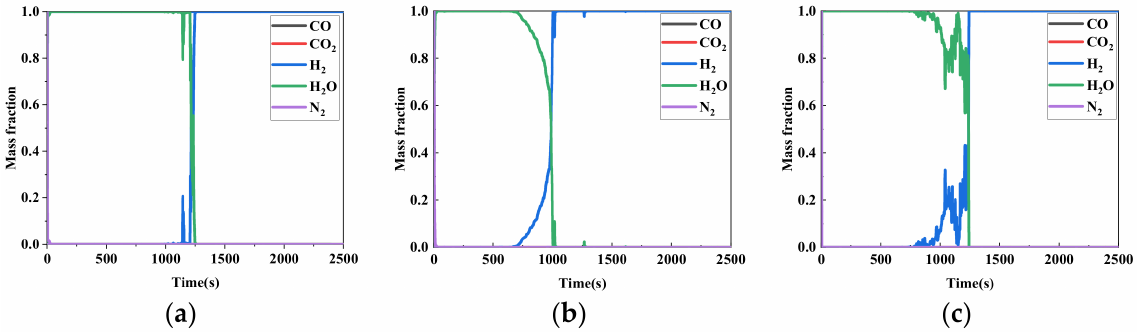
Figure 8. Changes in gas composition over time. ( a ) Experiments 1. ( b ) Experiments 2. ( c ) Experi- ments 3.